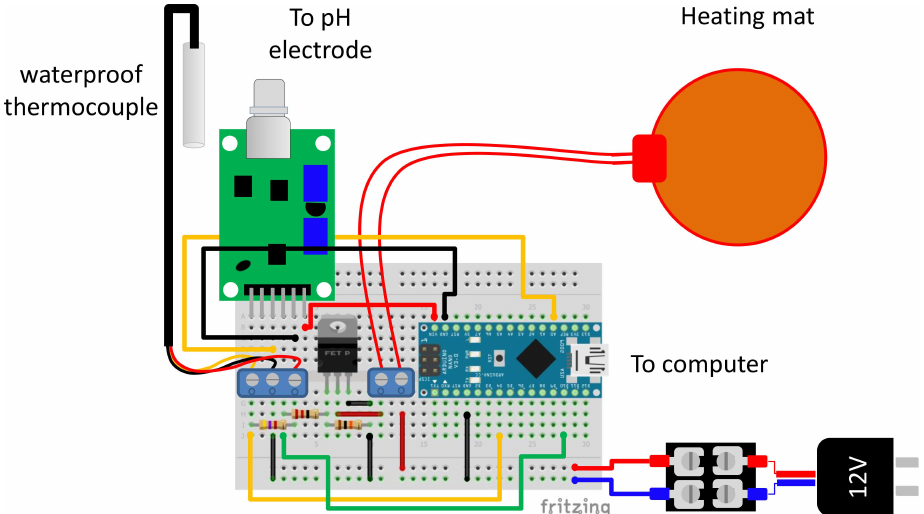
Figure 2. Schematic representation of the Arduino-based proportional integral derivative (PID) temperature controller and online electric potential monitoring